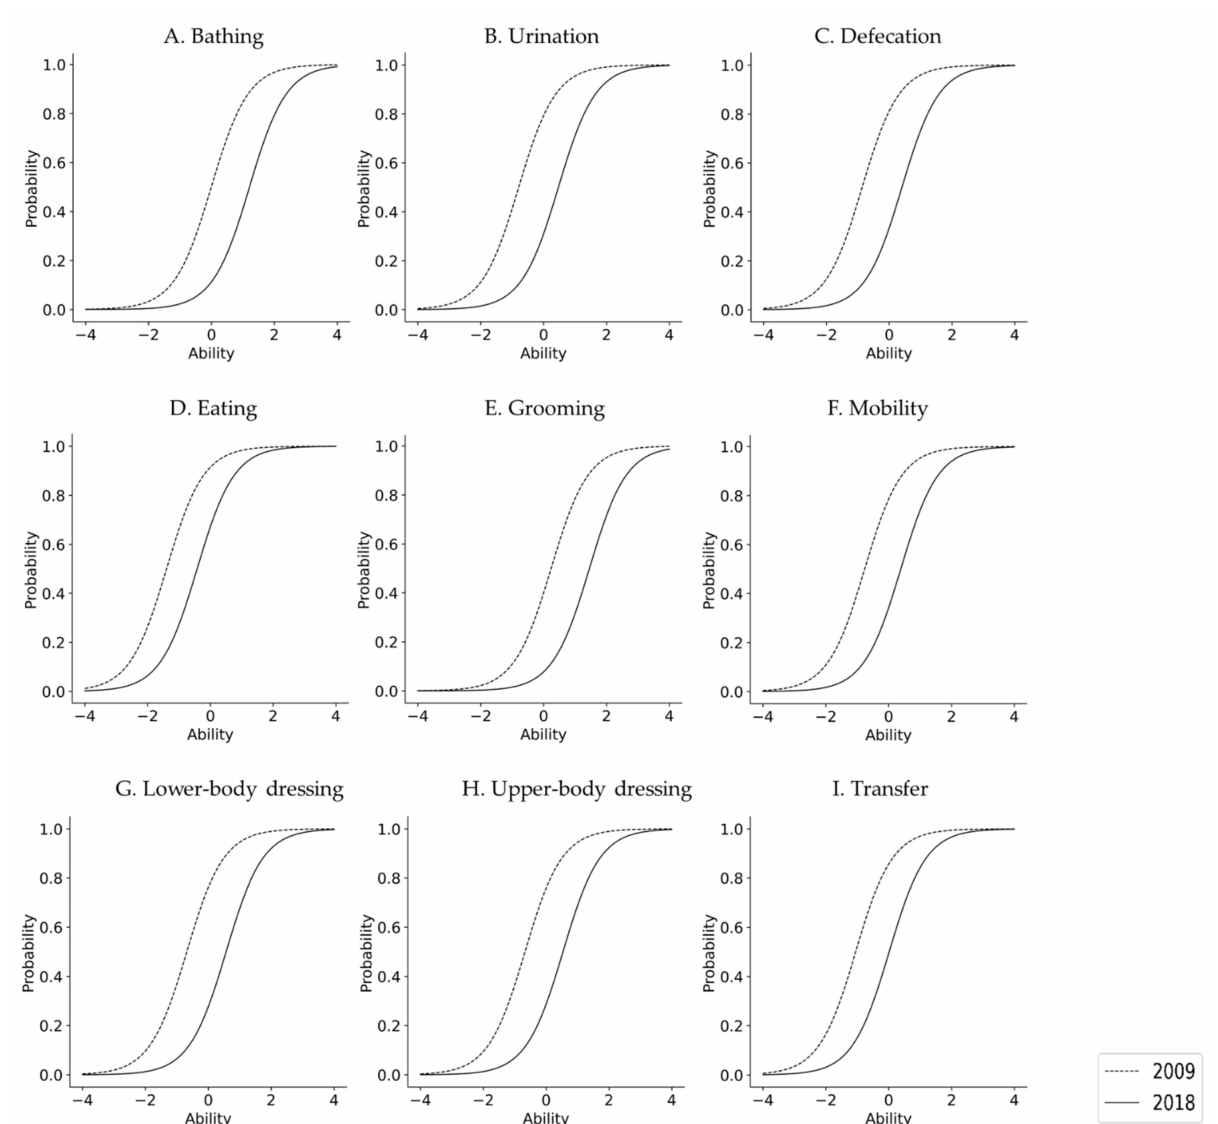
Figure 3. Difficulties in their ADL independence for women from 2009 to